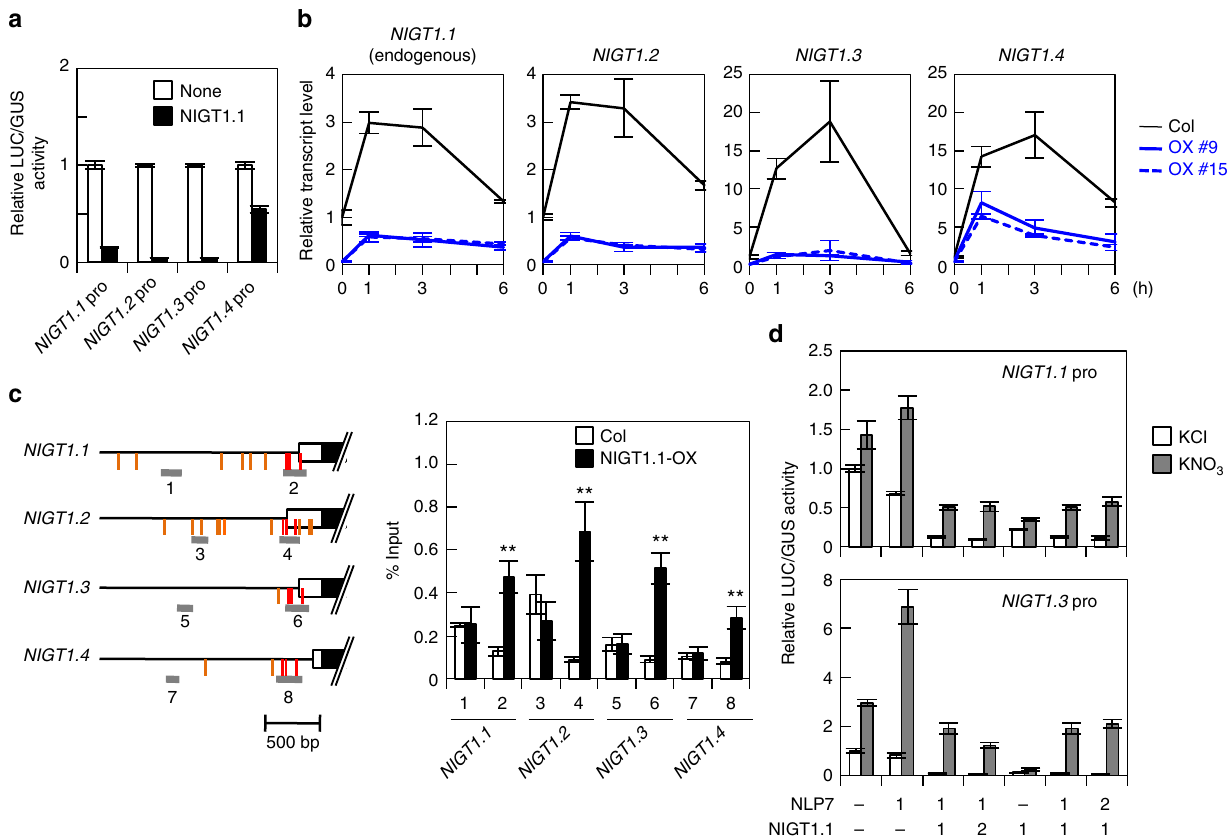
Fig. 6 Autoregulation of NIGT1-clade genes. a Repression of NIGT1-clade gene promoters by NIGT1.1. A reporter plasmid that contained the LUC gene under the control of an NIGT1 promoter was co-transfected in protoplasts alongside the NIGT1.1 expression vector and the UBQ10-GUS reference plasmid. LUC activity was normalised with GUS activity. Data are means ± s.d. of three biological replicates. b Reduced expression of endogenous NIGT1 . 1 as well as NIGT1 . 2 , NIGT1 . 3 and NIGT1 . 4 in NIGT1.1-OX lines. Ammonium-grown Arabidopsis Col and NIGT1.1-OX seedlings were treated with 10 mM KNO 3 for the indicated periods and used for RT-qPCR analysis. Values are normalised to UBQ10 expression levels, and means of biological triplicates with s.d. are shown. c Binding of NIGT1.1 to the NIGT1 gene promoters in vivo. ChIP analysis was performed with Col and NIGT1.1-OX seedlings. Two different promoter regions were ampli fi ed from immunoprecipitated DNA. Data are means of four biological replicates with s.d. ** p < 0.01 by one-tailed t test compared with corresponding values obtained with Col seedlings. Positions of the conserved and nonconserved putative NIGT1-binding sites are shown by vertical red and orange lines, respectively. d Antagonistic regulation of NIGT1-clade gene promoters by NLP7 and NIGT1.1. Expression vectors for NLP7 and NIGT1.1 were co-transfected into protoplasts at different ratios, together with a reporter plasmid containing the LUC gene under the control of the NIGT1 . 1 or NIGT1 . 3 promoter. Transfected protoplasts were incubated in the presence of 10 mM KCl or KNO 3 . LUC activity was normalised with GUS activity, and relative LUC activities are means± s.d. of three biological